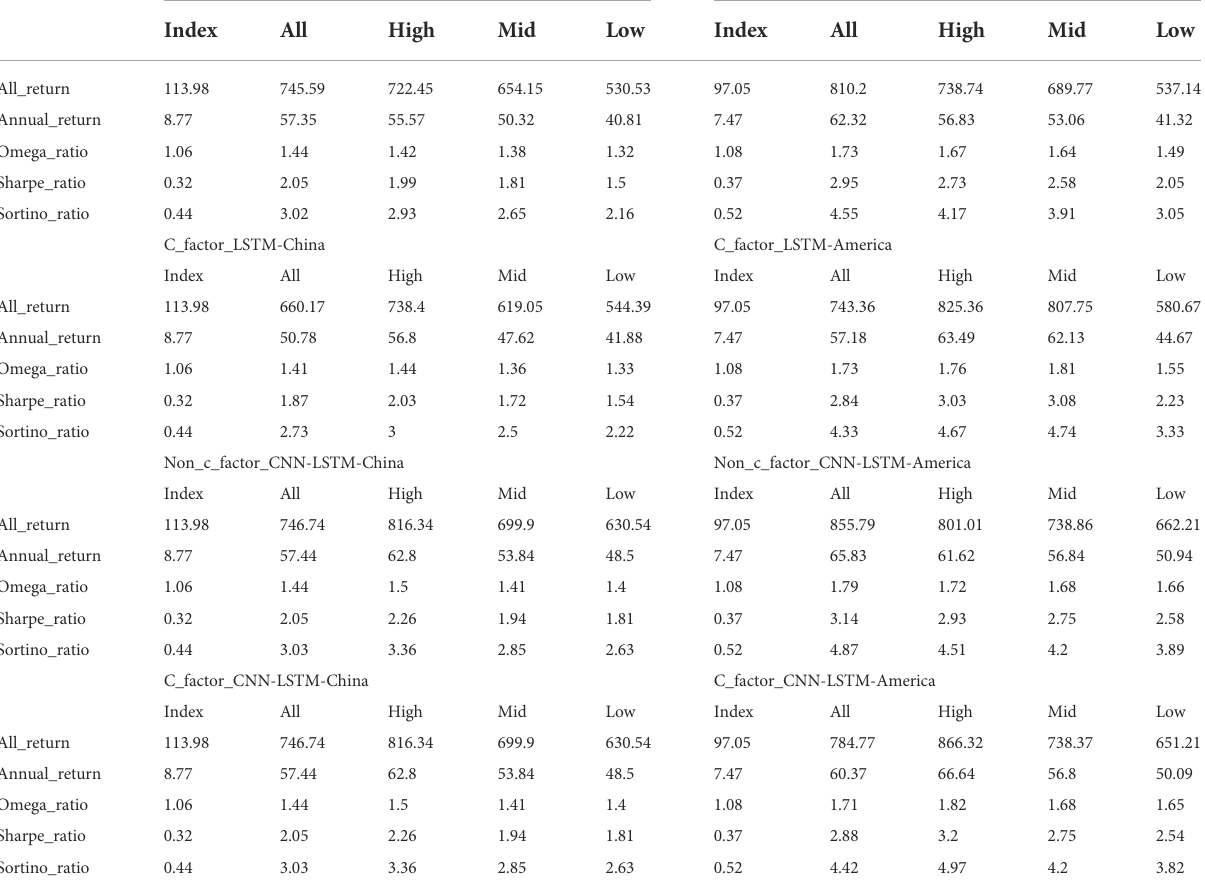
TABLE 2 Evaluation of performance of portfolio using Multi-LSTM method and CNN-LSTM method with and without carbon factor in feature engineering Note: This table records the values of total return, average return, omega ratio, Sharpe ratio and Sortino ratio used to evaluate the performance of portfolio of Multi-LSTM method and CNN-LSTM method. And all, high, mid as well as low represent the full stock, high-carbon, medium-carbon as well as low-carbon sectors respectively. Meanwhile, the values of Chinese market and American market are recorded respectively.AndSSECompositeIndexisselected asbenchmarkinChina,whiletheS&P500isselectedinAmerica.Comparedtothebenchmark, the fi ve measures of investment performance of the portfolio constructed by this methodology far exceed the benchmark, implying a signi fi cantly higher return per unit of risk, which is a positive prediction. Non_c_factor_LSTM-China